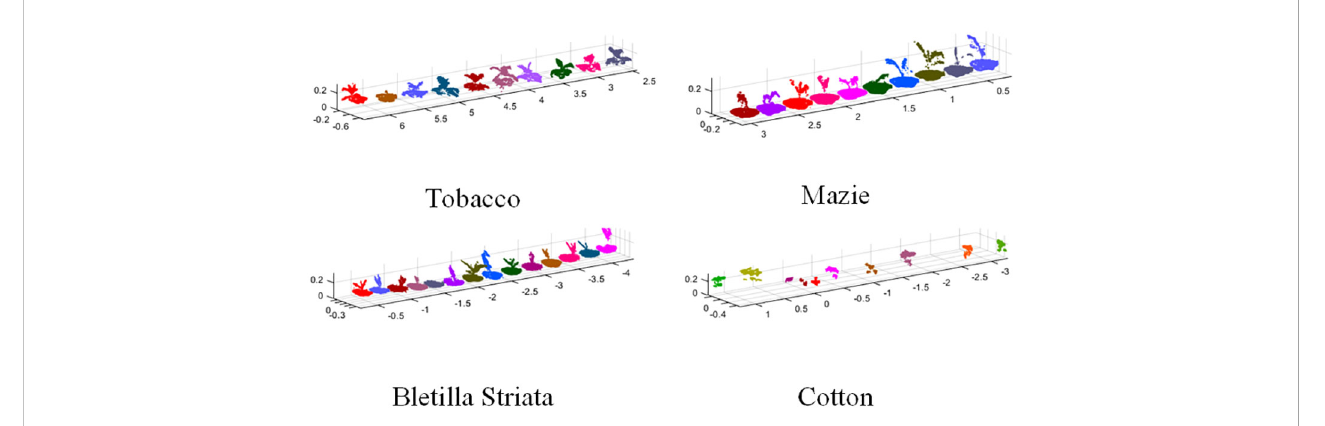
FIGURE 5 Results of point cloud preprocessing for different